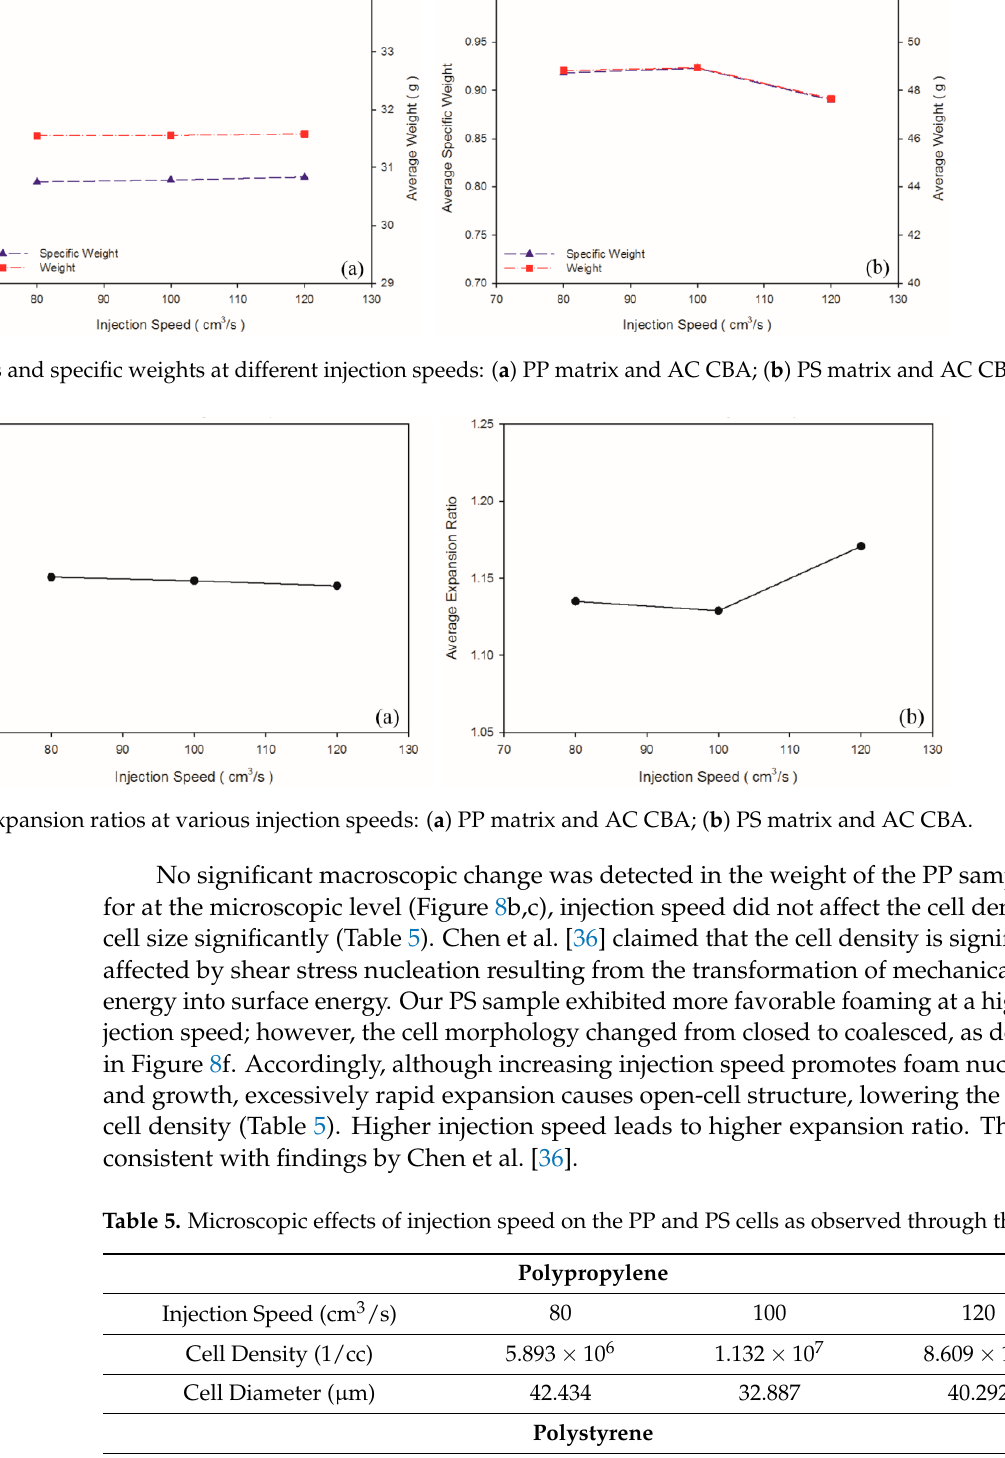
Figure 8. SEM micrographs of PP processed with different injection speeds: ( a ) 80 cm 3 /s, ( b ) 100 cm 3 /s, ( c ) 120 cm 3 /s; SEM micrographs of PS processed with different injection speeds: ( d ) 80 cm 3 /s, ( e ) 100 cm 3 /s, ( f ) 120 cm 3 /s.